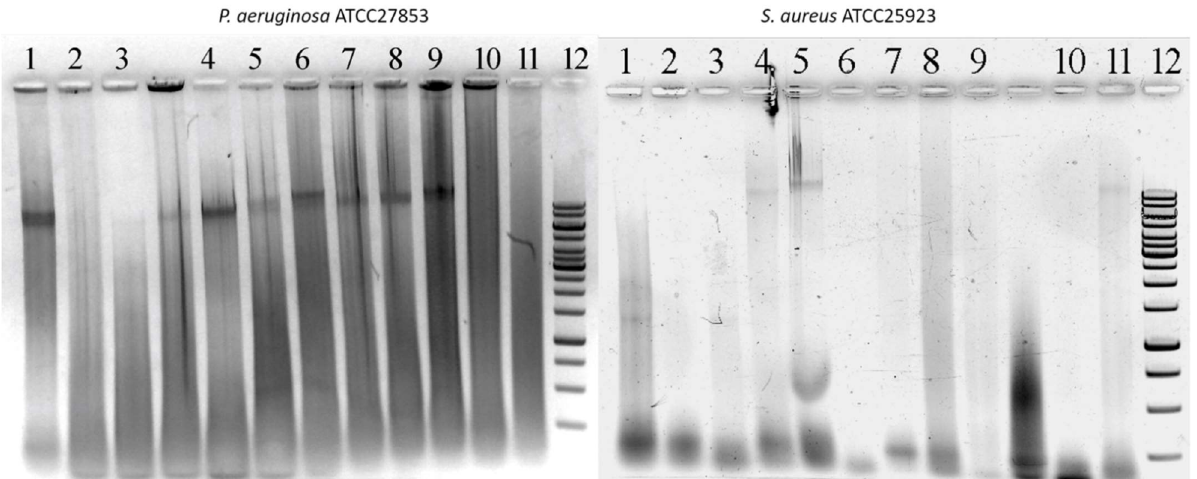
Figure 2. High-molecular-weight and degraded eDNA released from 5-day-old dehydrated Pseu- domonas aeruginosa ATCC 27853 (PA) and Staphylococcus aureus ATCC 25923 (SA) biofilms after treatment with biocides. Shown here are 1.2% agarose-TA gels stained with EtBr to visualize the eDNA released from PA (left) and SA (right) biofilms after 1 h of exposure to biocides. Treat- ments: (1) water-only control, (2) 0.1% PHMG-Cl, (3) 0.05% PHMG-Cl, (4) 6% hydrogen peroxide, (5) 3% hydrogen peroxide, (6) 70% ethanol, (7) 0.05% chlorhexidine, (8) 0.25% Maxisan, (9) Arquades- plus, (10) Desmanol, and (11) Sanikon. A sample of GeneRuler 1 kb DNA Ladder (Thermo